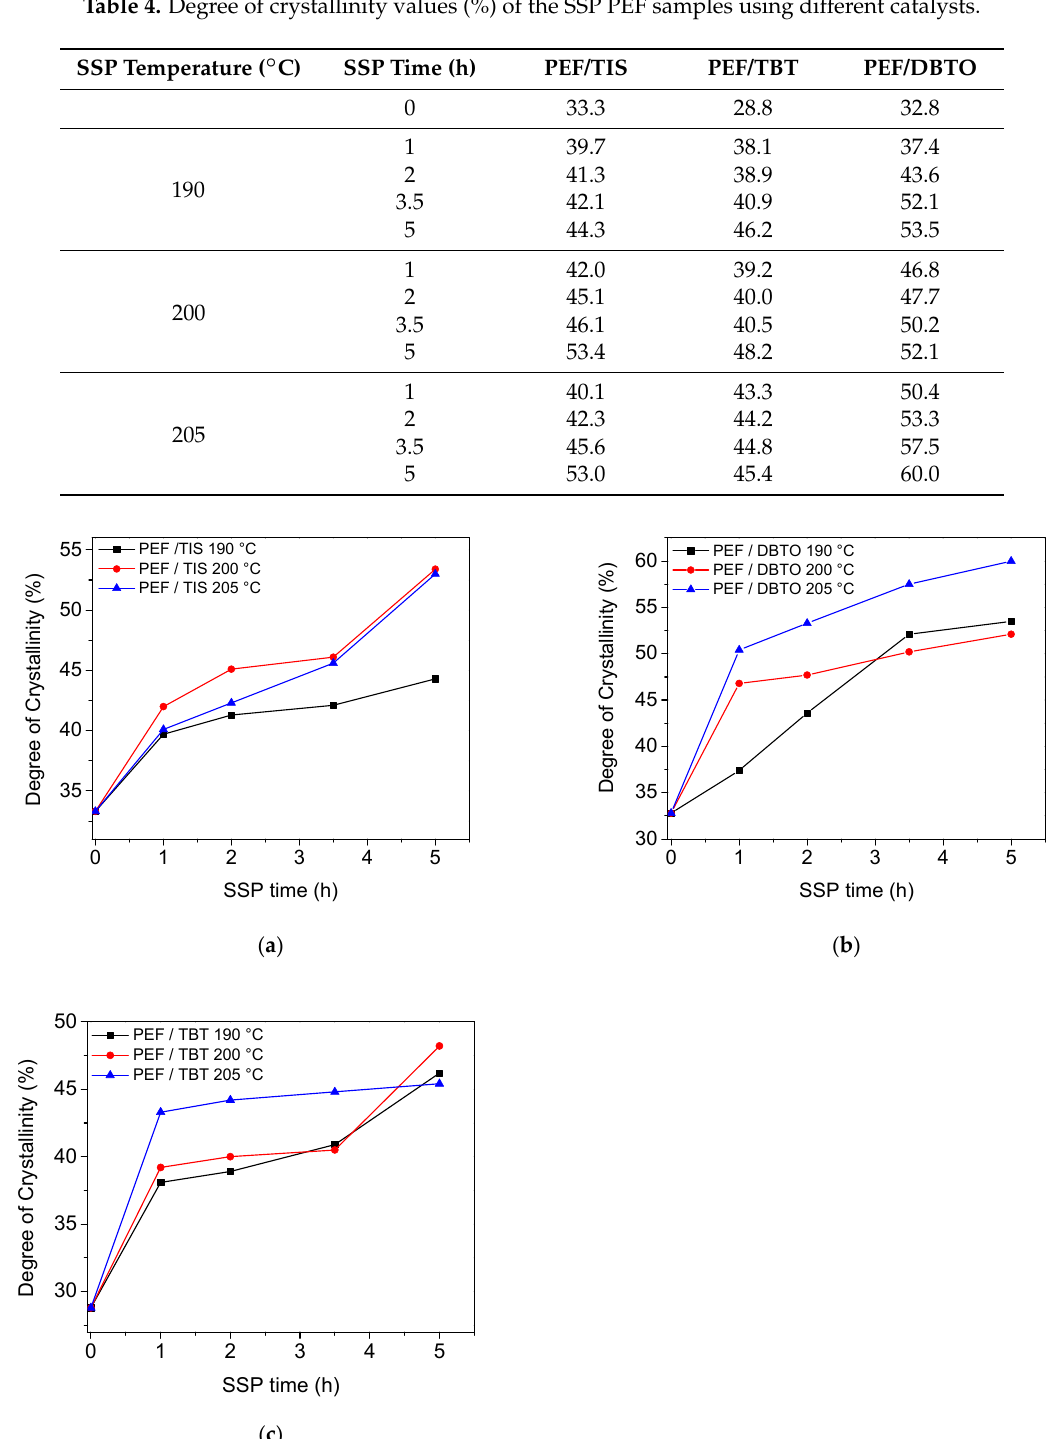
Table 4. Degree of crystallinity values (%) of the SSP PEF samples using different catalysts. SSP temperature (°C)